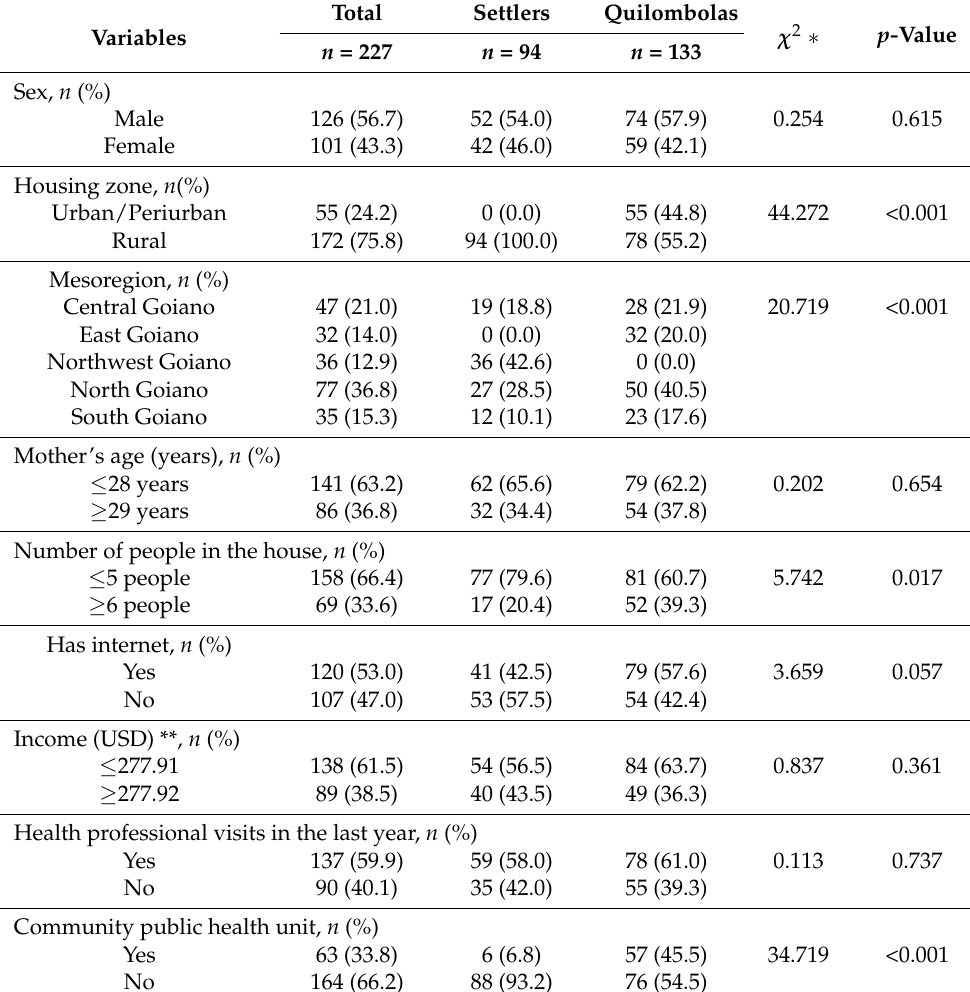
Table 2. Sociodemographic characteristics according to the type of community of 227 settled and quilombola children in the state of Goi á s,